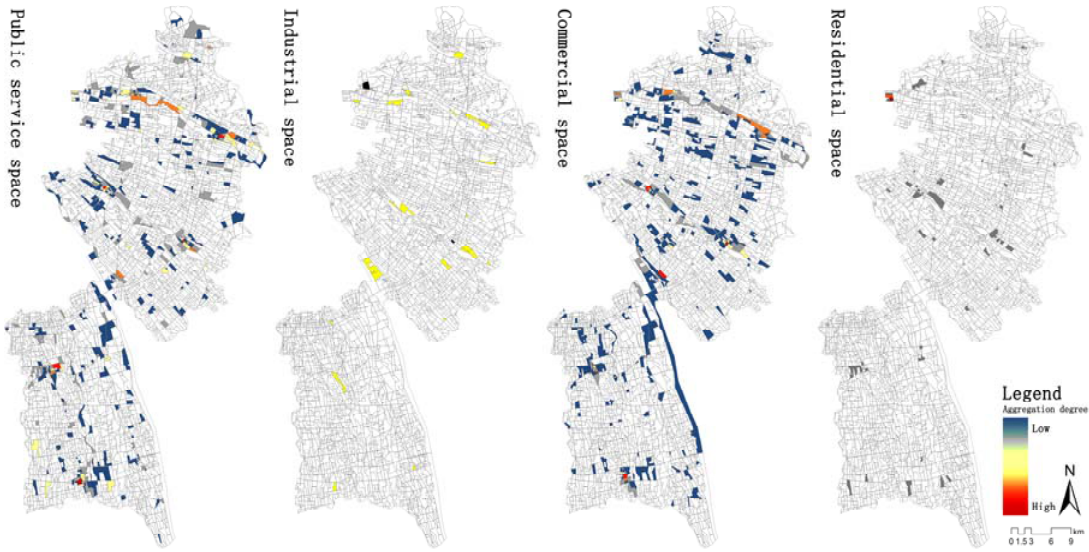
Figure 6. Aggregation of each functional